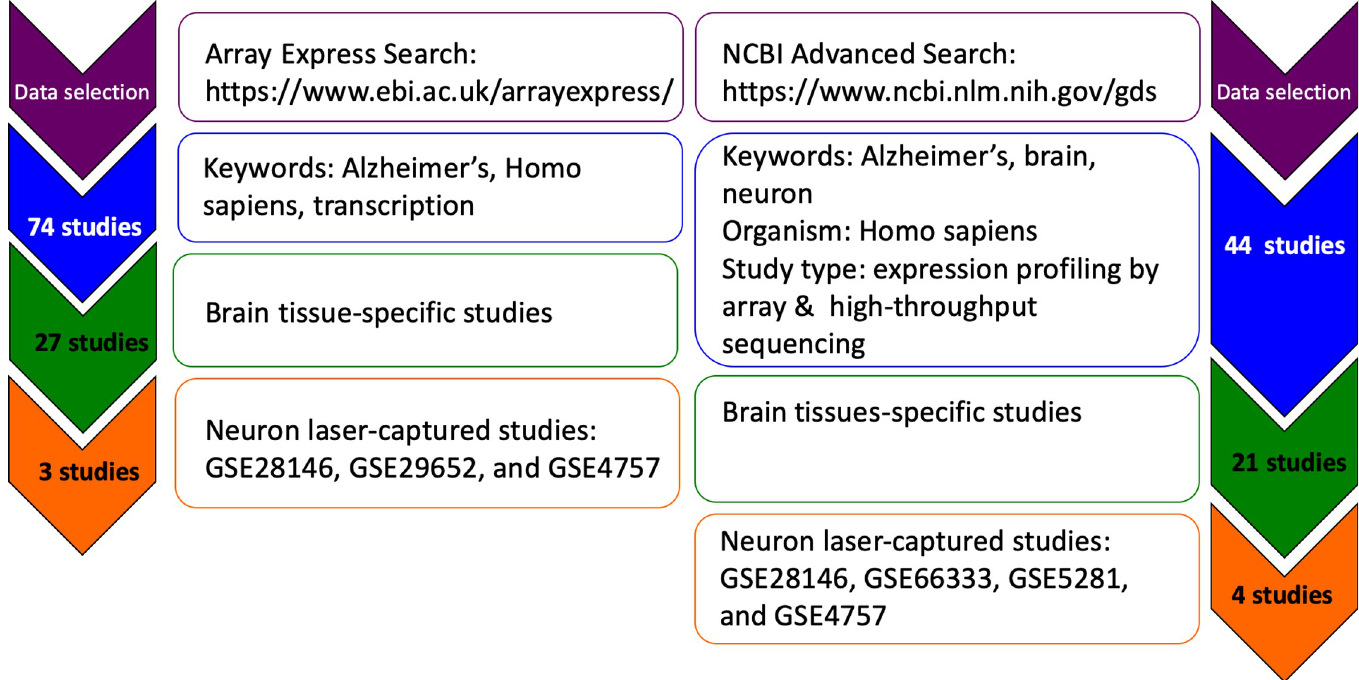
Fig 1. Database mining. The NCBI GEO database (https://www.ncbi.nlm.nih.gov/gds) and ArrayExpress database (https://www.ebi.ac.uk/arrayexpress/) were searched on June 3, 2019 for studies in which gene expression data was available from laser-captured neurons in the brain of Alzheimer’s patients.